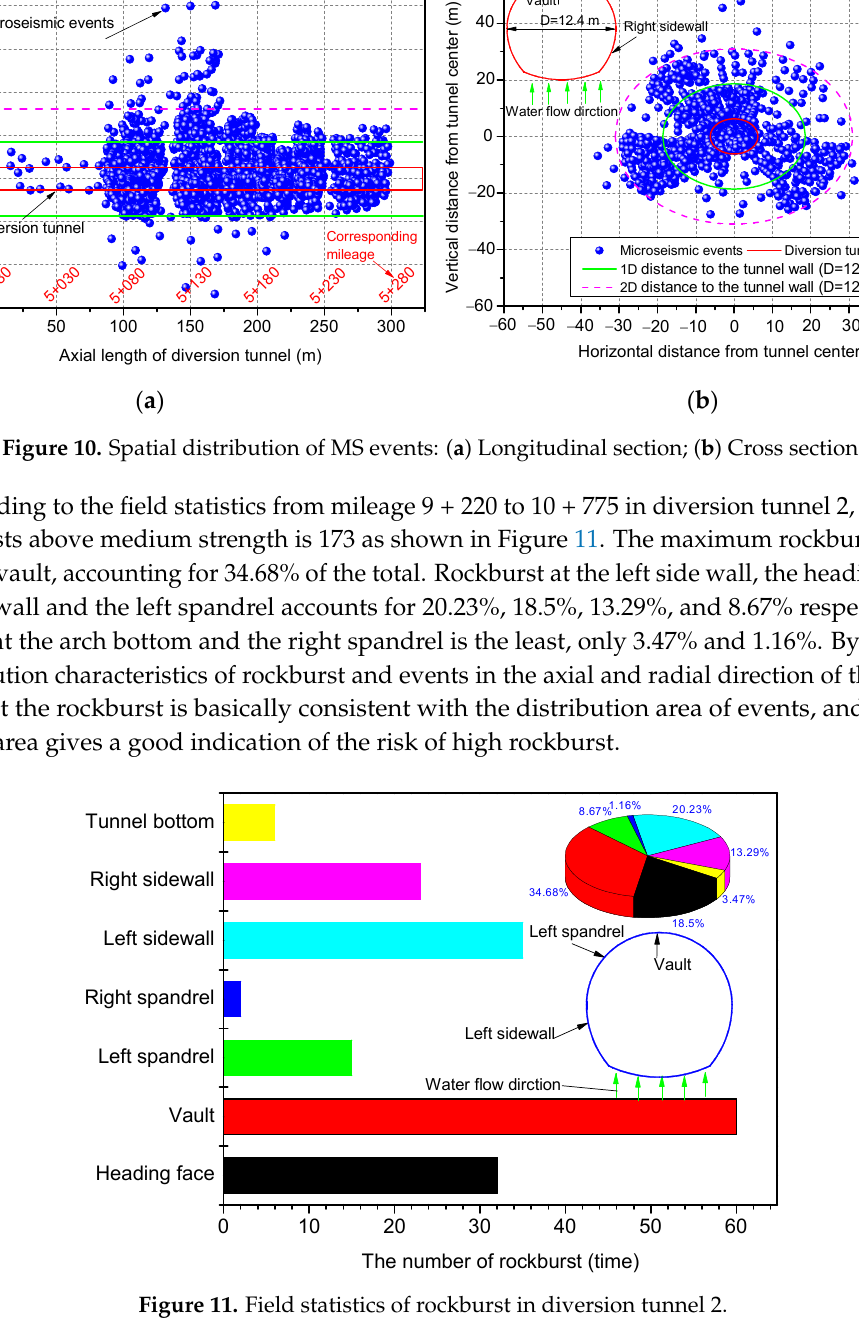
Table 1. Statistics of the rockburst length in different stratum.